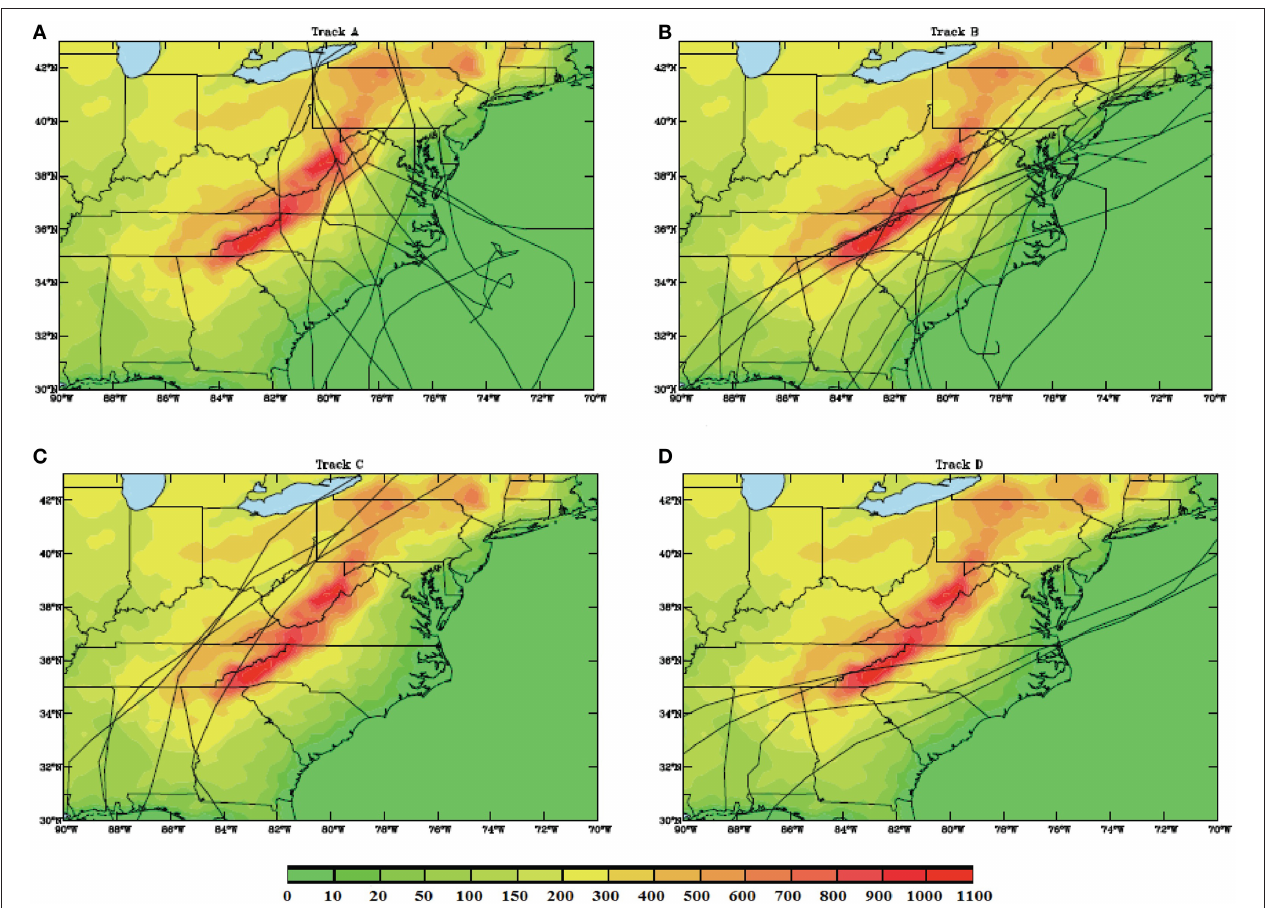
FIGURE 1 | Classification of track categories (A–D) for hurricanes passing over the South-Central Appalachian (SCA) mountain range (Harville, 2009